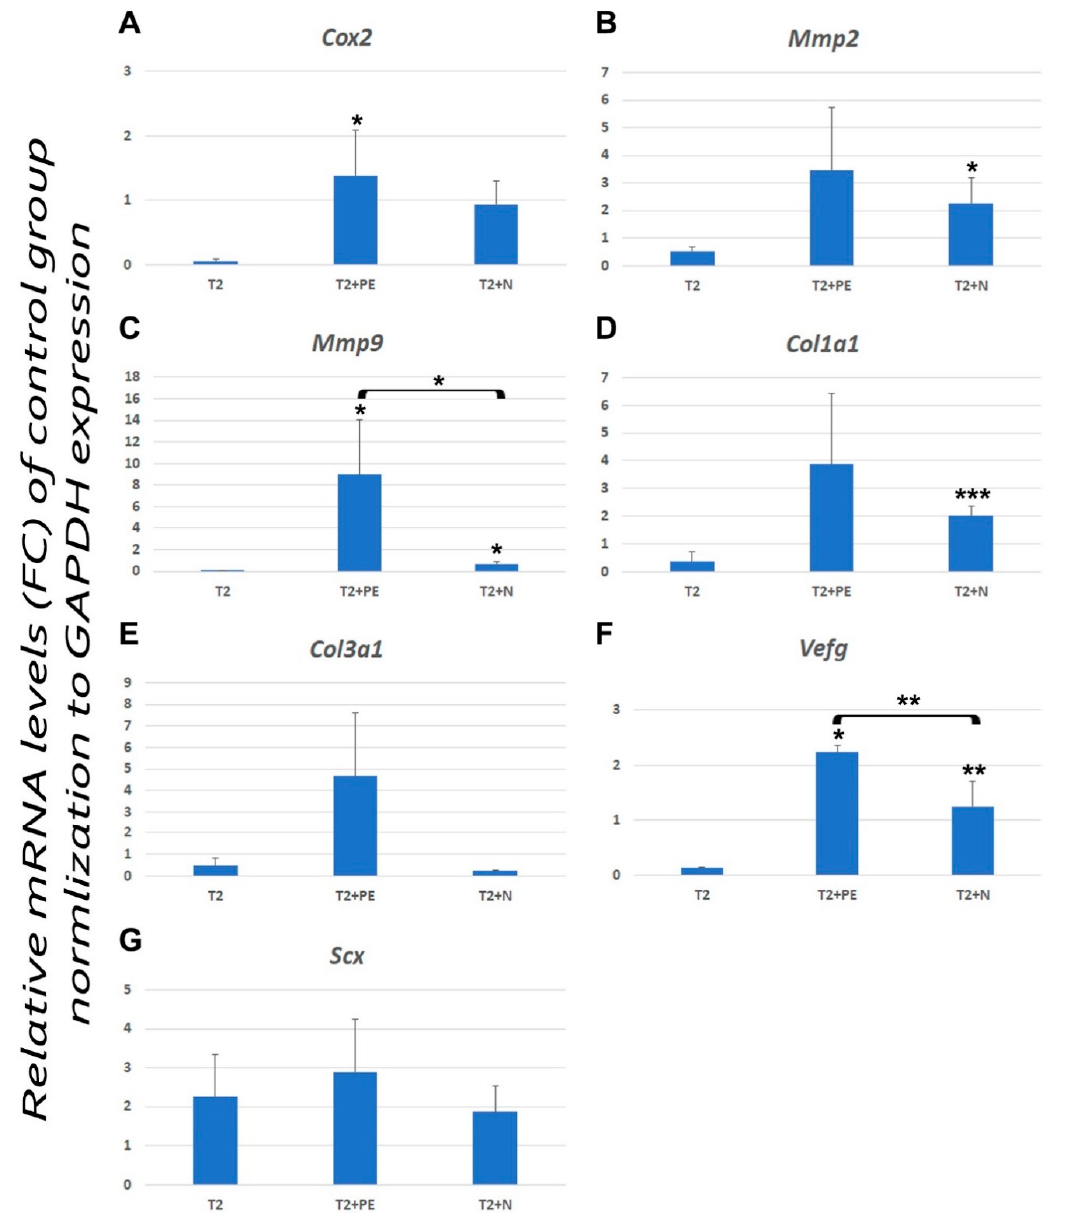
Figure 7. Levels of expression of Cox2 ( A ), Mmp2 ( B ), Mmp9 ( C ), Col1a1 ( D ), Col3a1 ( E ), Vegf ( F ) and Scx ( G ) genes in an injured Achilles tendon with collagenase injection by group: no intervention (T2), percutaneous electrolysis (T2 + PE) and needling (T2 + N). Data were quantified and normalized by using the RT-qPCR procedure. Each bar represents the fold change (FC) ± standard deviation (SD). *** p < 0.001; ** p < 0.01; * p < 0.05. Table 4. Gene Expression Levels in Experimentally induced Tendinopathy Achilles Tendon of Rats (T2) according to intervention (no intervention, percutaneous electrolysis and needling).